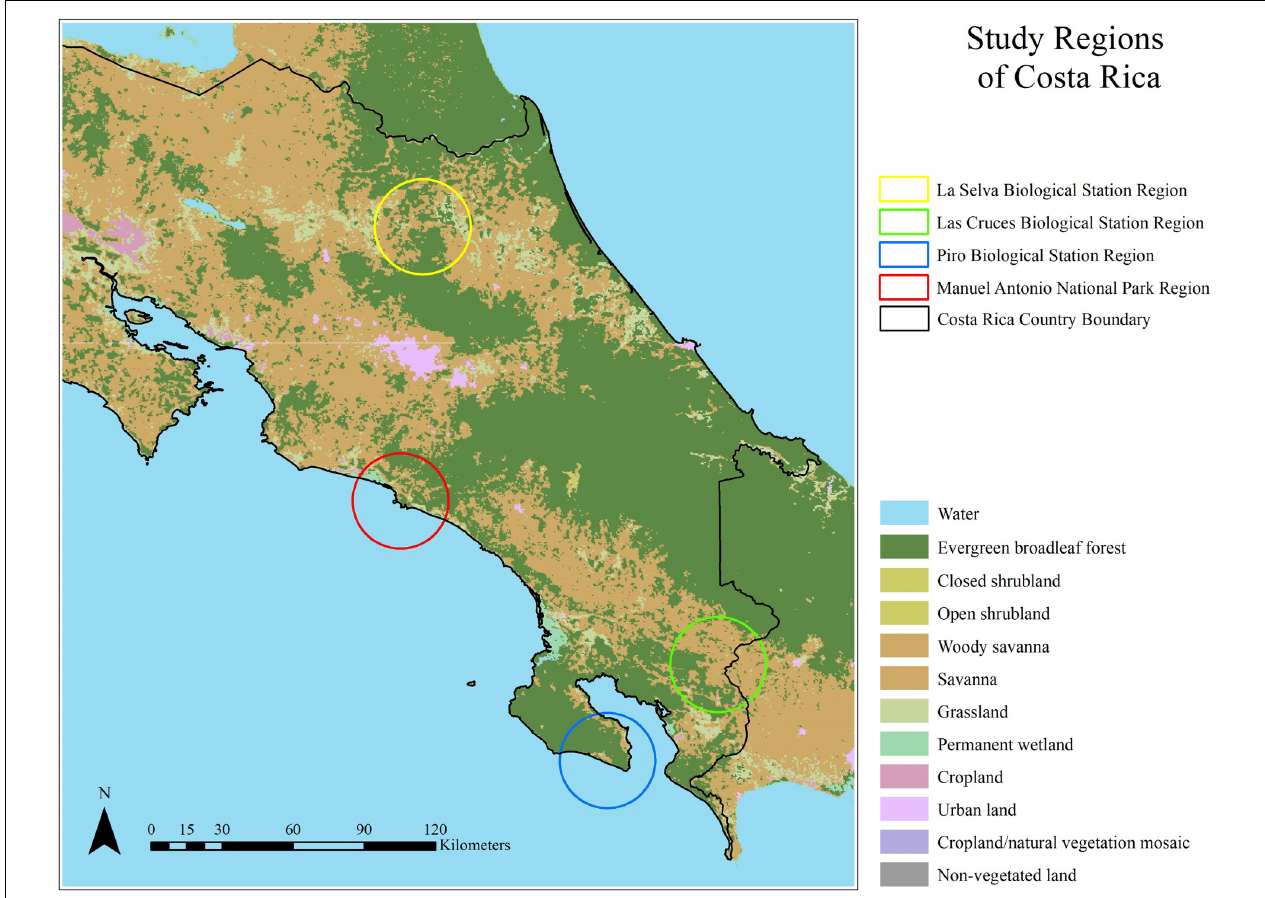
FIGURE 1 | Costa Rica land cover according to MODIS UMD classification with the four study regions surrounding La Selva Biological Station, Las Cruces Biological Station, Piro Biological Station, and Manuel Antonio National